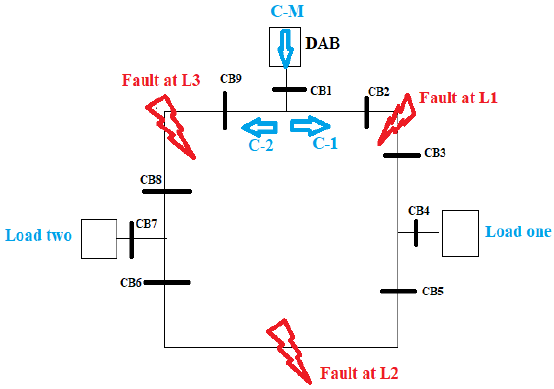
Figure 4. Proposed DCMG with possible line faults (F-L1, F-L2, and F-L3).